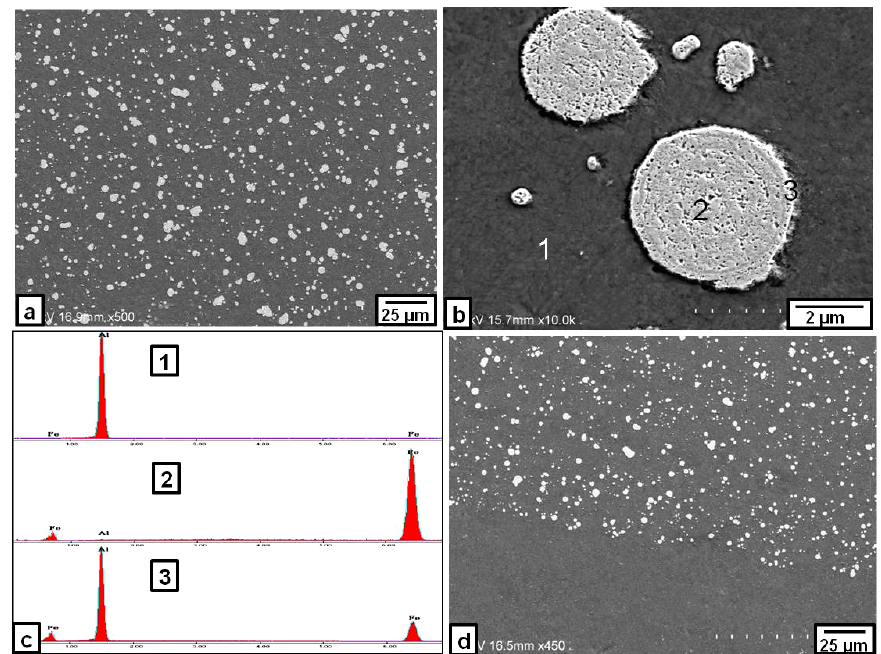
Figure 3. SEM image of the Fe particles dispersed in the nugget zone produced with triple FSP passes at a rotation speed of 1000 rpm: ( a ) nugget zone center; and ( b ) higher magnification of some Fe dispersed particles; ( d ) nugget zone bottom; and ( c ) the EDS spectra for point 1, 2 and 3 in ( b ).